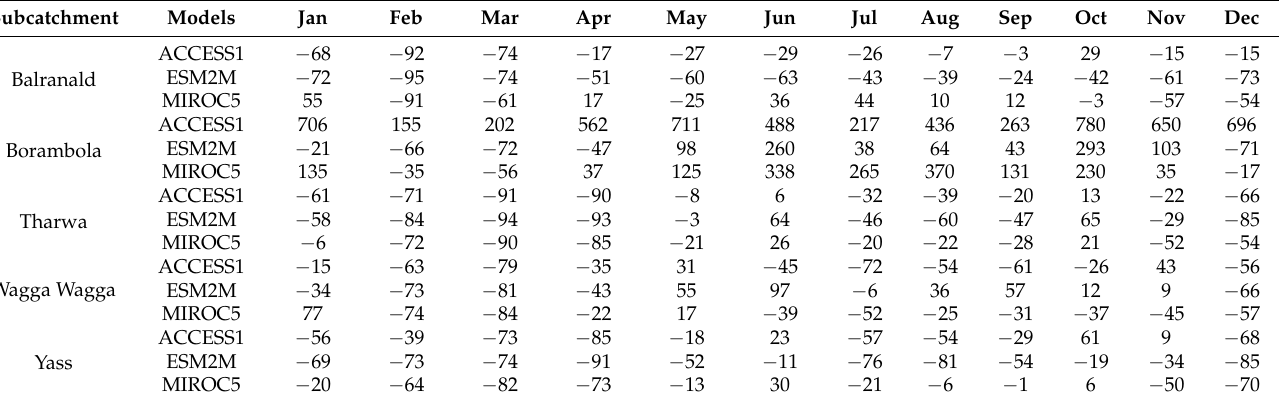
Table 5. Change (%) of runoff between simulated (using future climate data) compared to the historical for RCP 4.5 at sub-catchments of Murrumbidgee River basin.